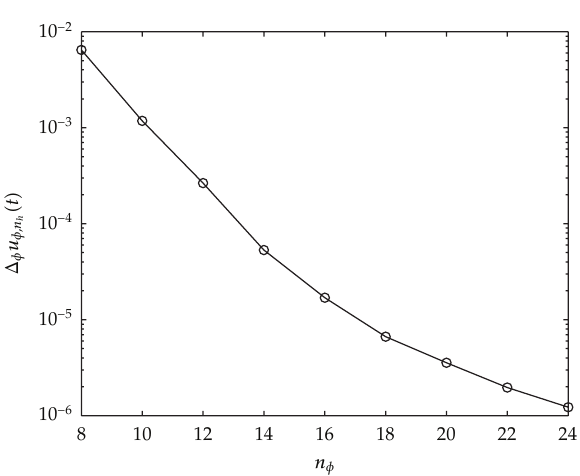
Figure 6: Error estimate (cid:4) 5.4 (cid:5) for one-dimensional case, for t (cid:2) 1 . 8, n h (cid:2) 121, α (cid:2) 1 , 5, k (cid:4) t (cid:5) (cid:2) cos (cid:4) t (cid:5) , and b (cid:4) t (cid:5) (cid:2) e − t . Periodic boundary